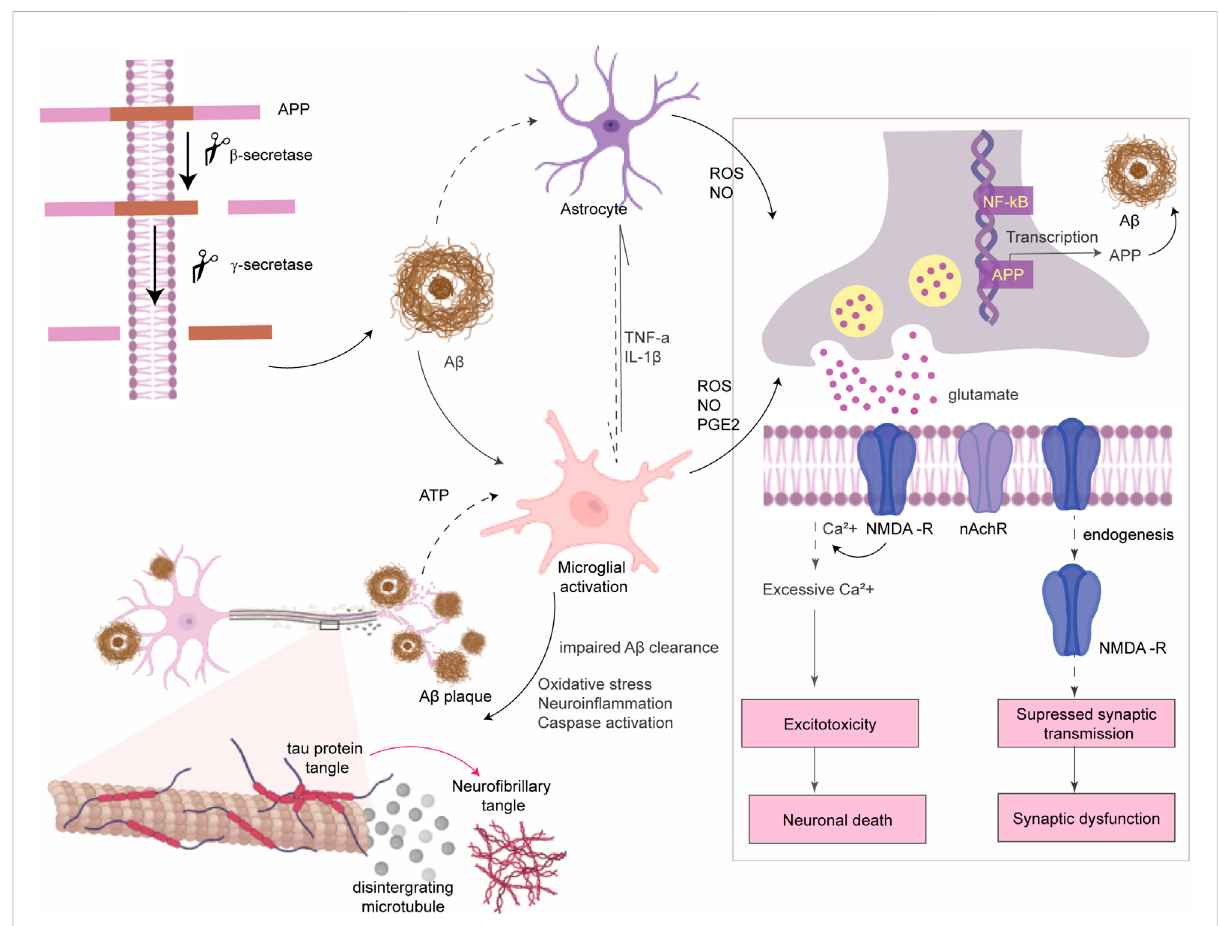
FIGURE 4 Amyloid β pathogenesis of AD. APP protein is processed by secretase enzymes to produce A β peptides. Aggregated A β causes microglial activation to produce ROS and in fl ammatory cytokines which further activate astrocytes. ROS binds to NF- κ B sites in the promoters of APP in neurons to activate transcription of the A β peptide. A β plaques enhance glutamate release from neurons and astrocytes. Prolonged activation of extrasynaptic NMDA receptors by excess glutamate leads to intense transient Ca 2+ in fl ux which alters some signaling pathways and causes neuronal death (excitotoxicity). A β also inhibits the activity of acetylcholine esterase and lowers the expression of nicotinic acetylcholine receptor (nAchR). In addition, A β accumulation promotes endocytosis of NMDA receptors at synapses which suppresses synaptic transmission and alters synaptic